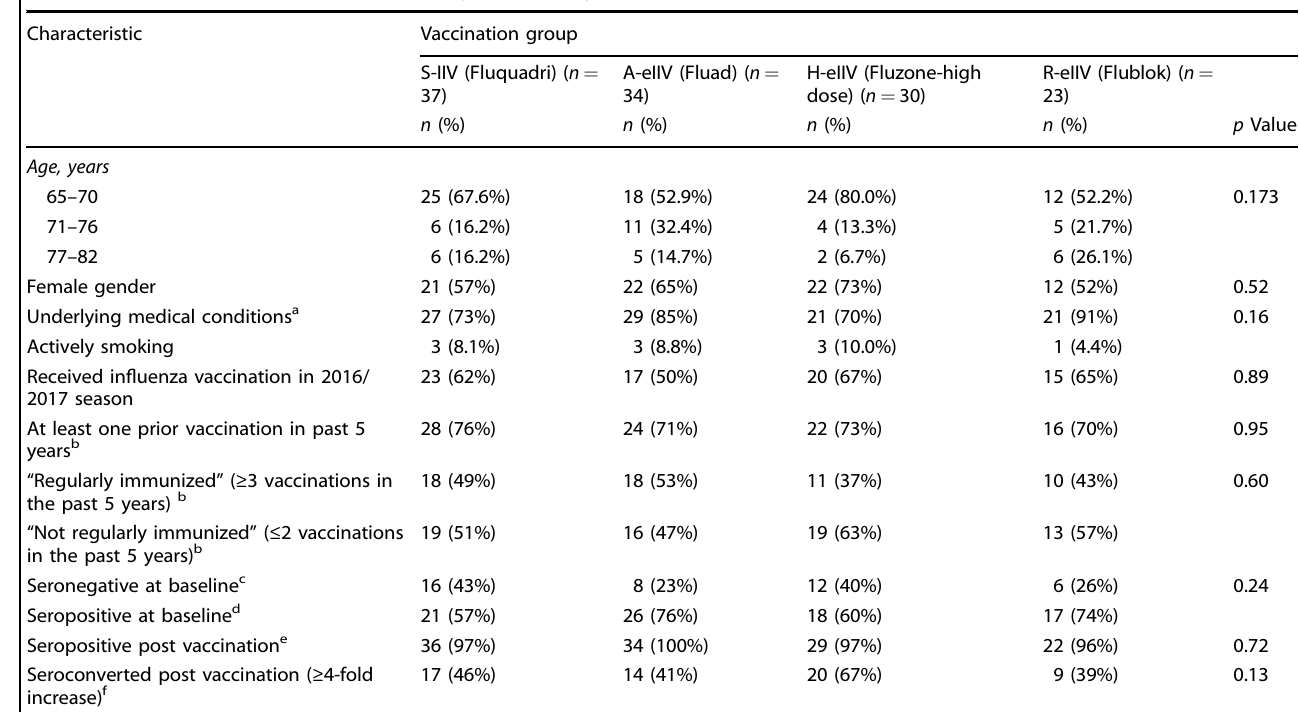
Table 1. Baseline characteristics of participants, by vaccination group.